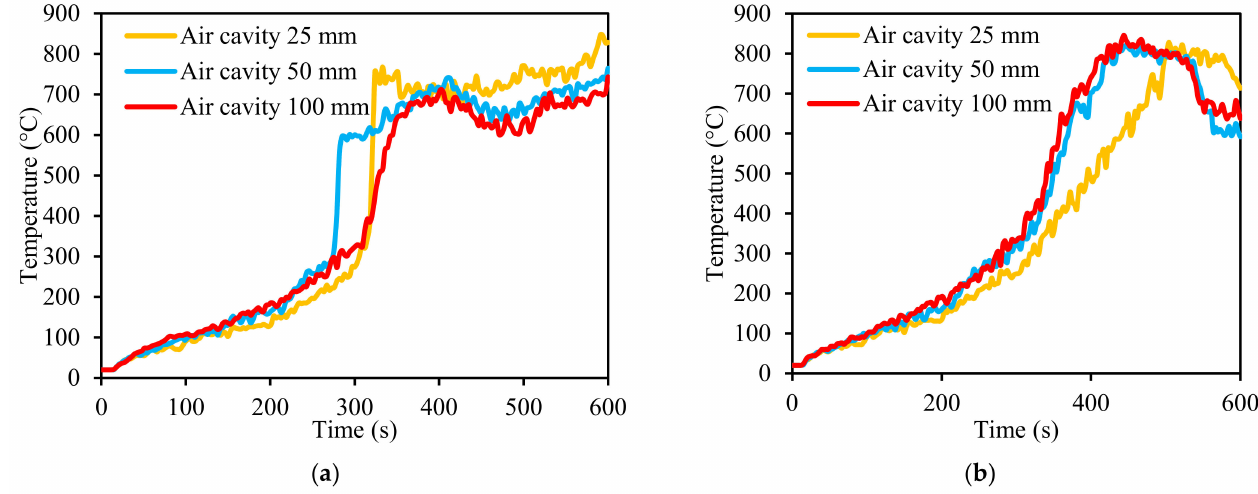
Figure 11. Air-cavity effect on ( a ) internal temperature and ( b ) external temperature.